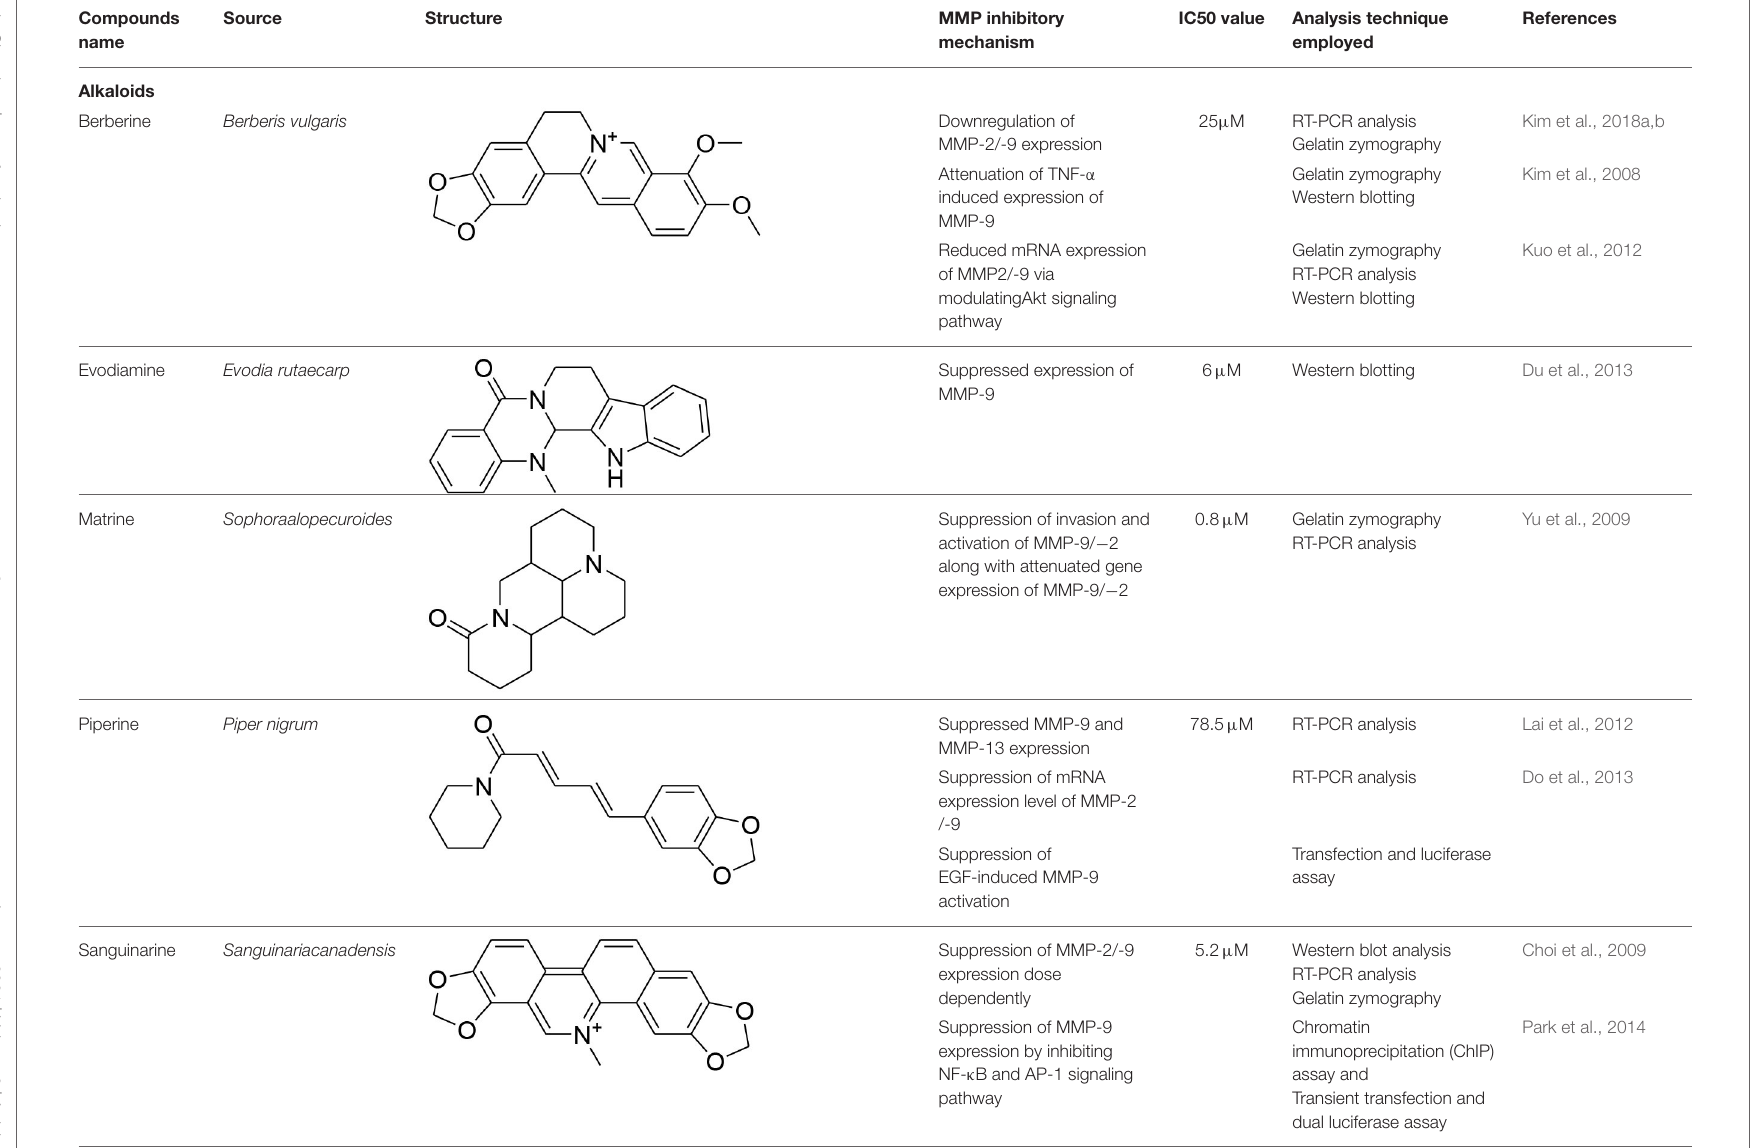
TABLE 1 | Phytochemicals modulating MMP activity by inhibiting its activation and associated signaling pathways. Compounds